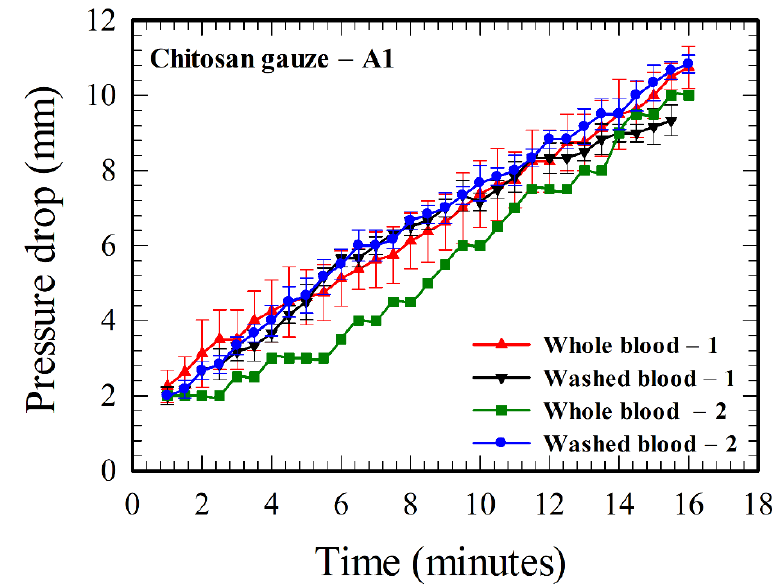
Figure 5. Comparison of the pressure drops across the chitosan gauze—A1 between the flows of whole and washed bloods at different values of hematocrit and pH (refer to Table 2).